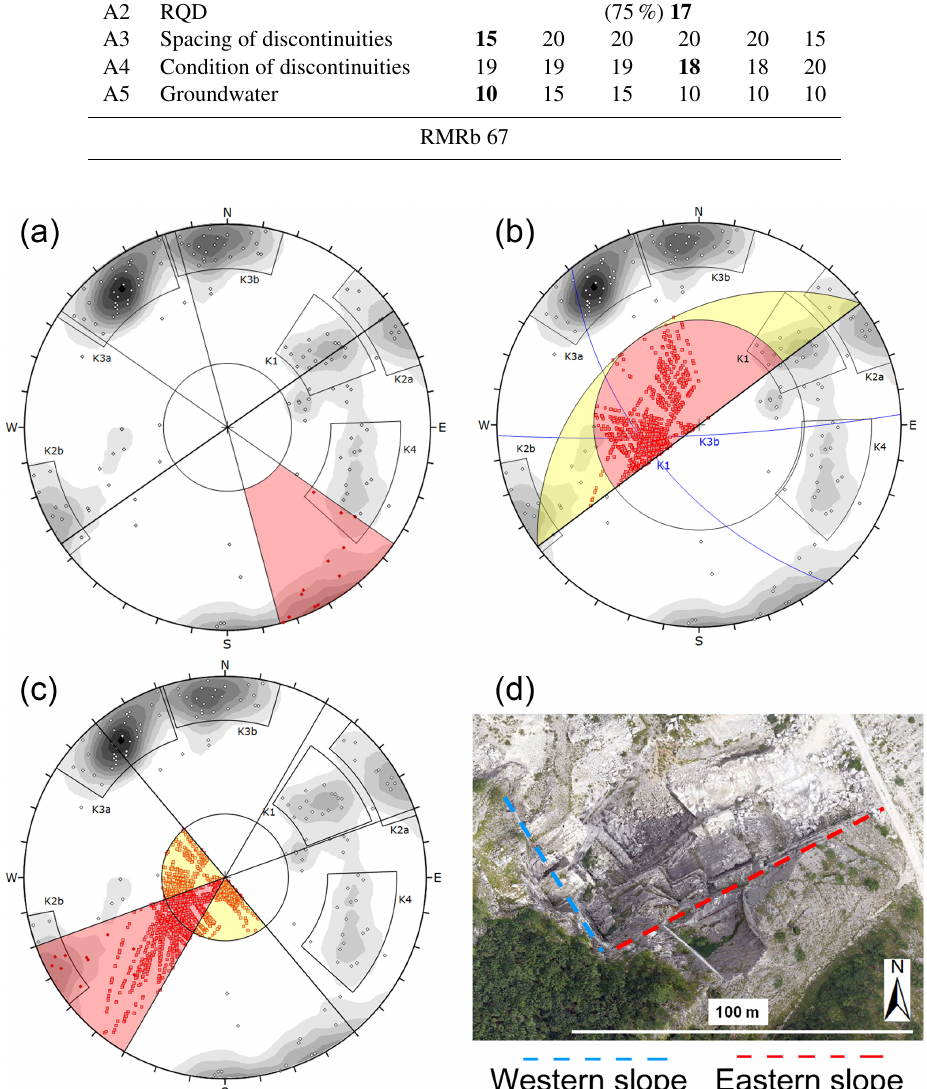
Figure 8. Examples of kinematic stability analysis carried out using Rocscience ™ Dips 6.0 stereographic projection through the Wulff equal-angle method (lower hemisphere): (a) planar sliding on the eastern slope; (b) wedge sliding on the eastern slope (with highlighted great circles of intersection K1/K3b as example); (c) direct toppling on the western slope; (d) aerial photo showing the two principal slope